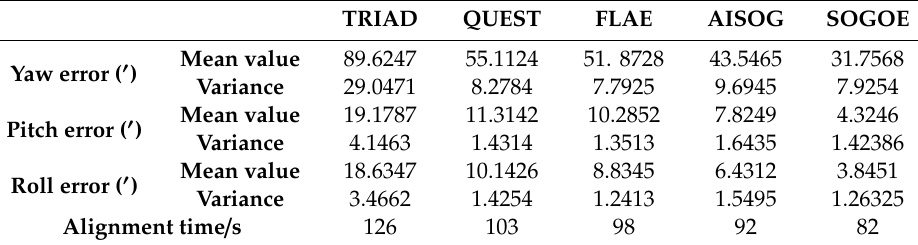
Table 6. Comparison of the attitude angle error and alignment time.